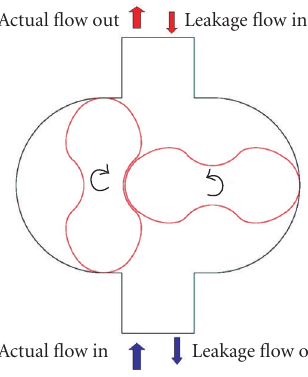
Figure 1: Schematic of a two-lobe Roots-type multi-recompression heater.